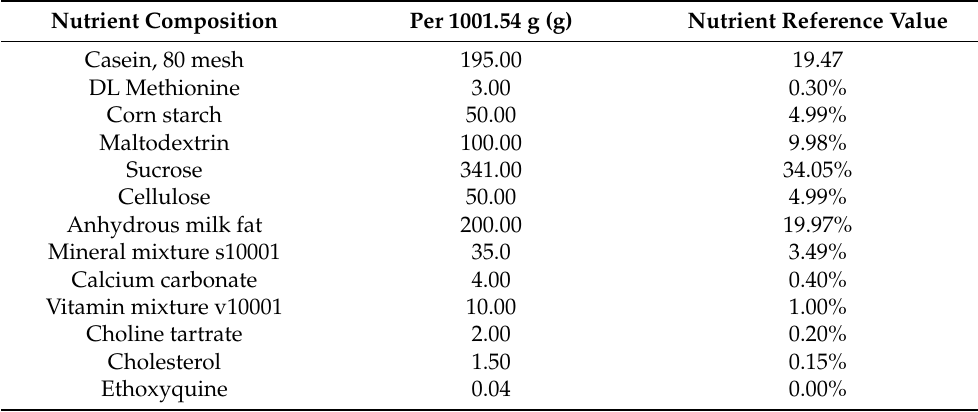
Table 1. Composition of the high-fat feed